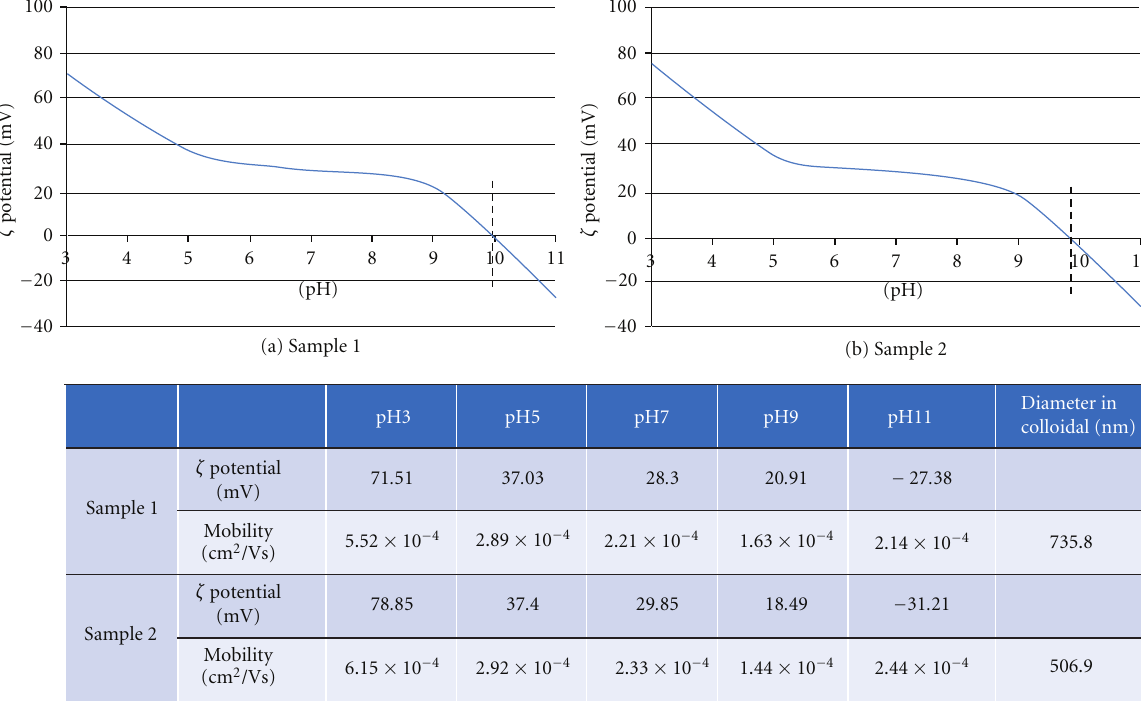
Figure 5: The zeta-potential data of an aqueous suspension of synthesized α -Al 2 O 3 , samples 1 and